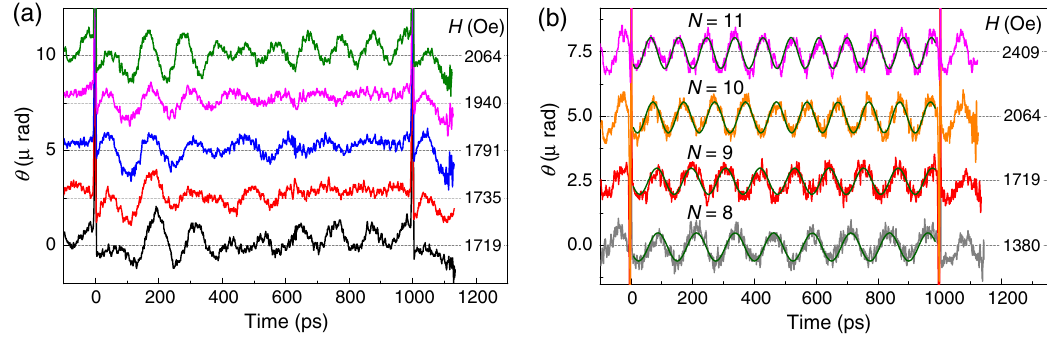
FIG. 2. Excitation of magnetization oscillation showing two precession modes in an iron-garnet film by a laser pulse train. (a) Magnetization oscillations at different magnetic fields. (b) Consecutive resonances of the slowly decaying precession mode B for different magnetic fields. The green thin lines are fits with decaying sine functions. The fit parameters are given in Table SIII (see Ref. [30]). The experimental data are presented for sample 2.